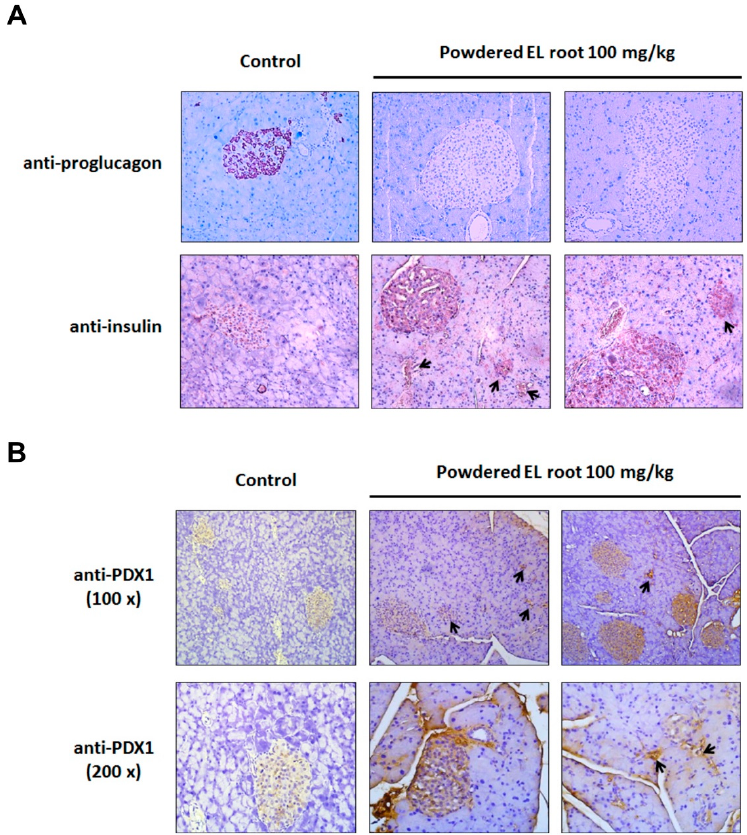
Figure 6. E. longifolia increased PDX1 expression and increased β -cell number. Representative images showed the immunostaining of glucagon ( A , upper panel ), insulin ( A , lower panel ) and PDX1 ( B ) in pancreas slices. ( A , B ) The glucagon-producing α -cells were stained brown and nuclei stained blue. A notable reduction in α -cell population was presented in the EL-treated group, as compared to that in the control. The insulin-positive cells are dominantly present inside the islets, but also found in pancreatic ducts. Moreover, a stronger immunoreactivity to insulin was presented in the EL-treated mice, as compared to the control group. ( B ) A similar pattern was found in the immunostaining of PDX1, a biomarker of beta-cell neogenesis. More PDX1-positive cells were stained in islets and pancreatic ducts of the EL treated mice. This finding suggested the regeneration of beta-cells through an induction of PDX1.